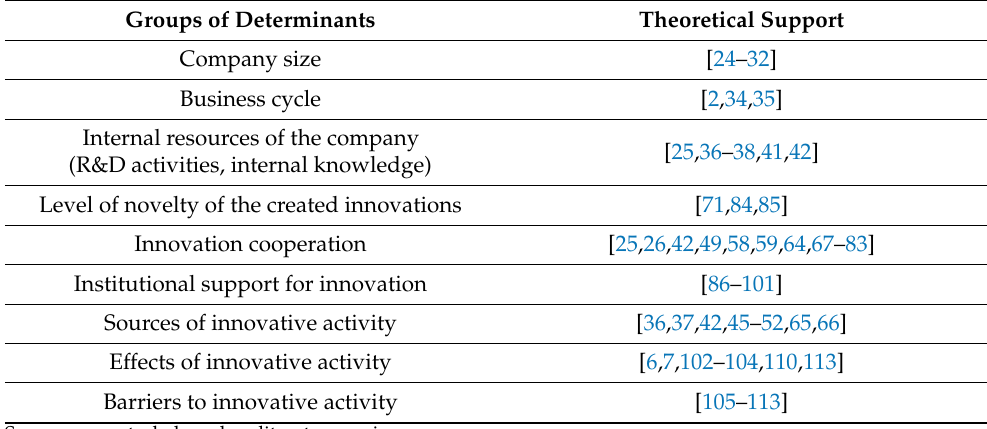
Table 1. Potential determinants of